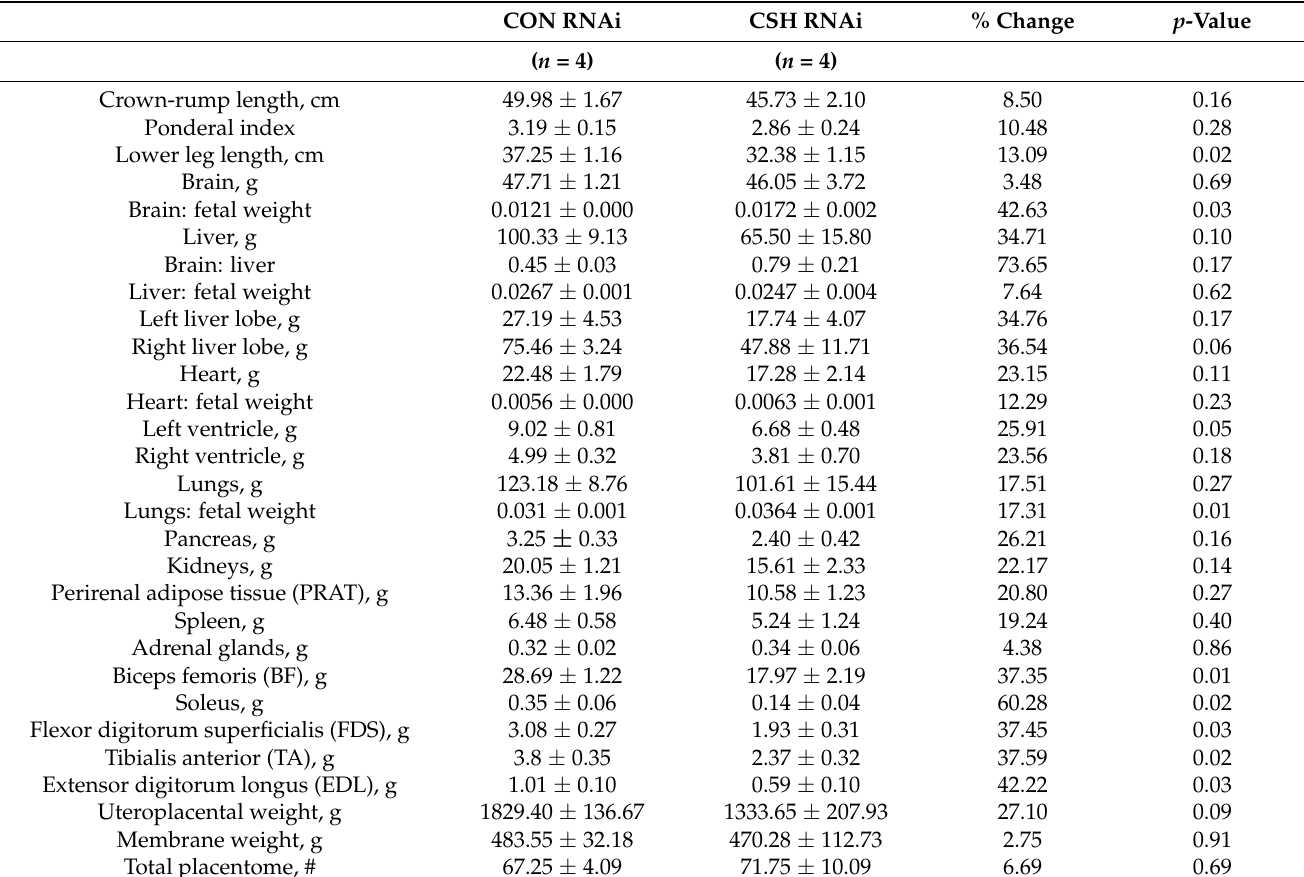
Table 3. Fetal weights, growth parameters, and uteroplacental characteristics assessed at necropsy (130 dGA). CON